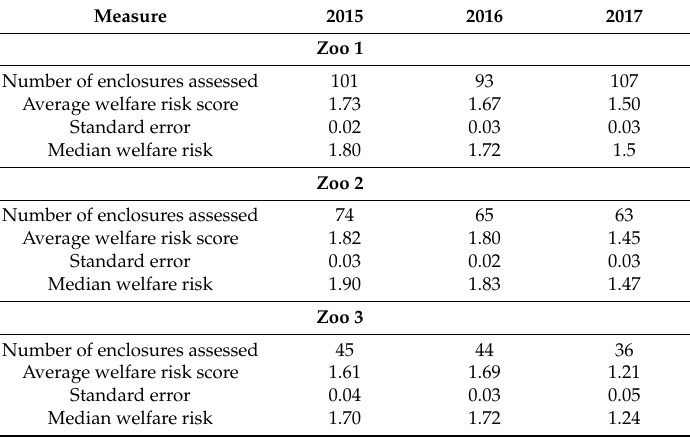
Table 3. Total number of enclosures assessed, the mean welfare score, standard error, and median welfare risk at each zoo in each year of the